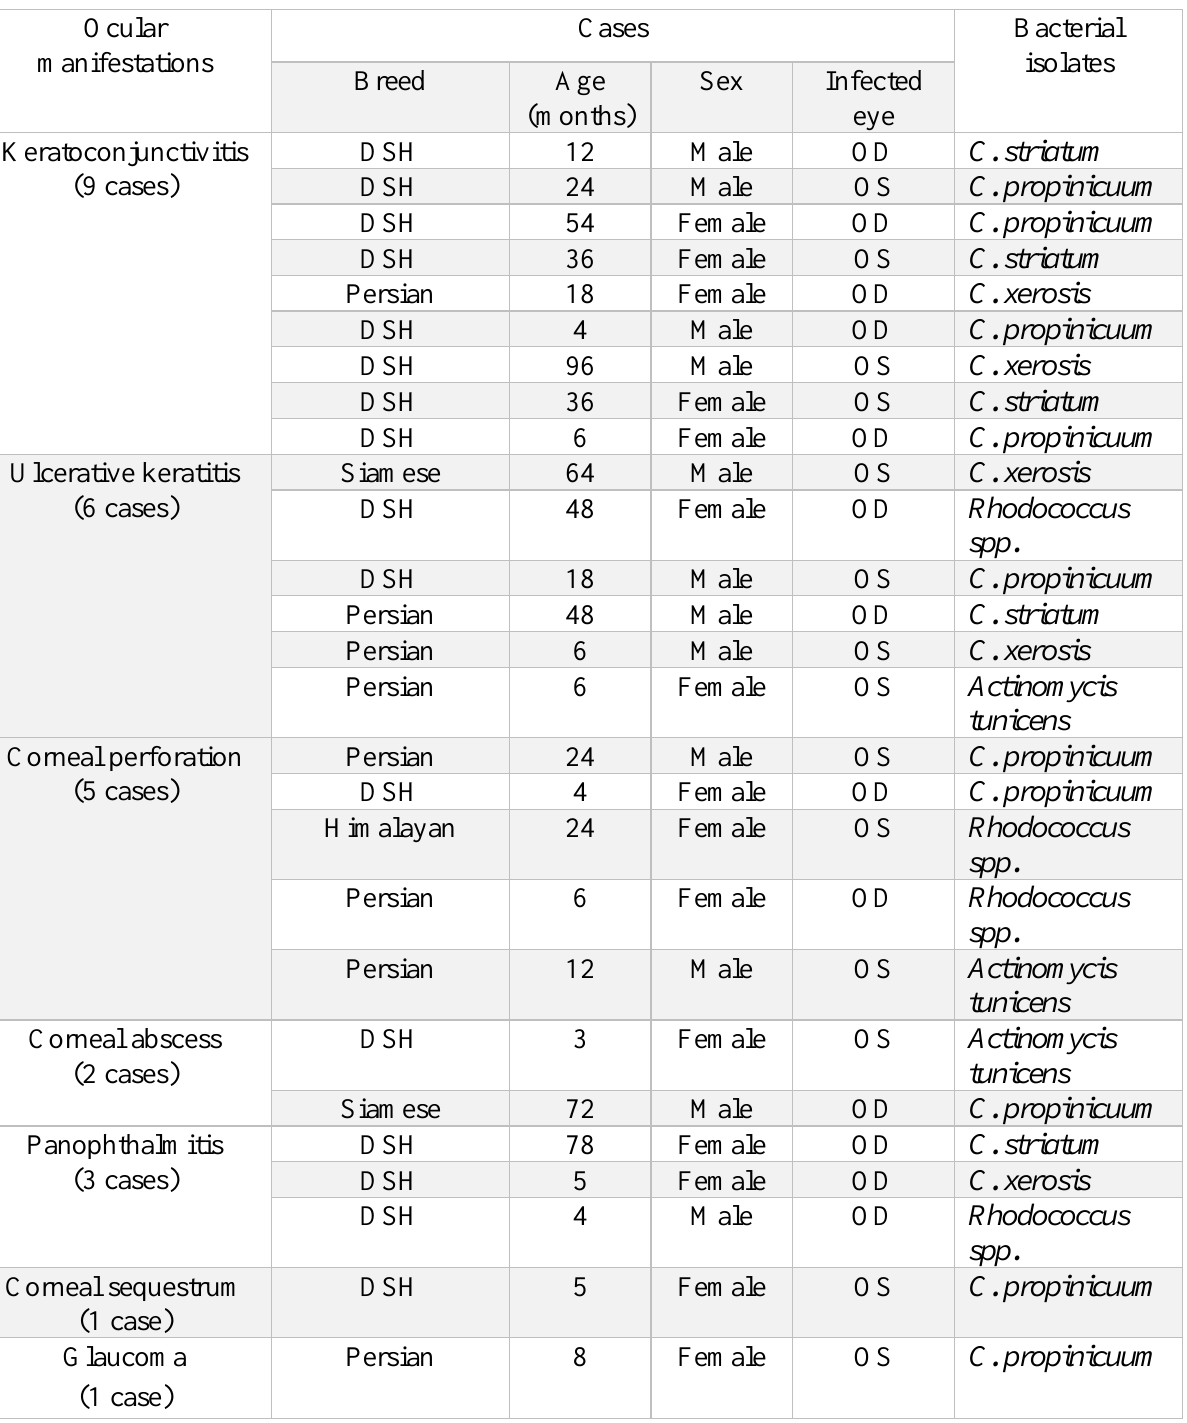
OD: Oculus Dexter, OS: Oculus